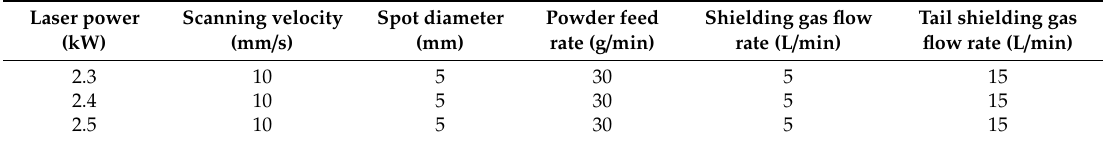
Table 2. Processing parameters for laser cladding.